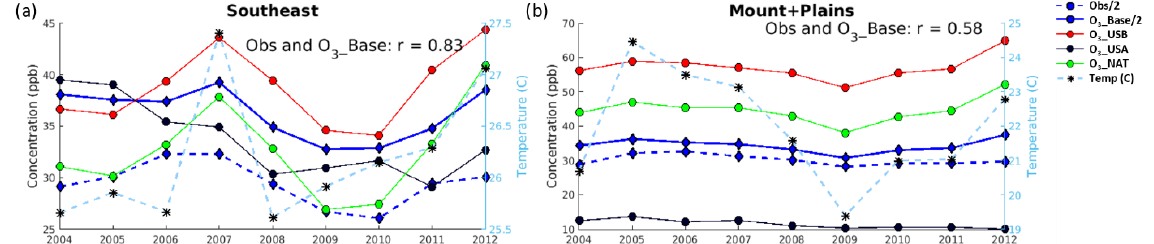
Figure 6. Average yearly MDA8 O 3 _top10obs_JJA concentrations for observations (divided by 2 to fit on the same axes; blue dashed line), O 3 _Base (divided by 2; blue solid line), O 3 _USB (red), O 3 _USA (black), O 3 _NAT (green), and daily average temperature (in ◦ C; light blue) in the (a) Southeast and (b) Mountains and Plains regions on the O 3 _top10obs_JJA